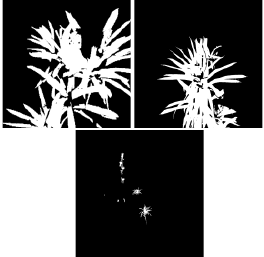
Figure 2: Binary annotated ground-truth corresponding to the images in above figure. The target epiphyte is in white and the background is in black